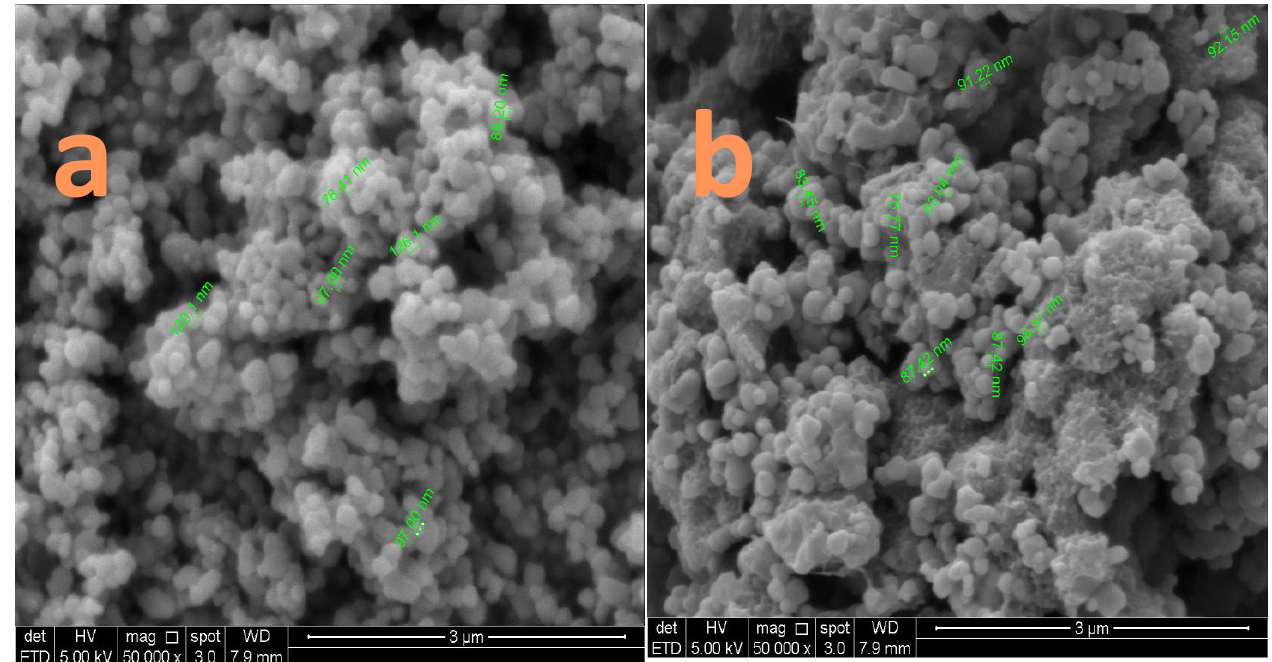
Figure 1. SEM image of ZnO ( a ) and ZnO/GO ( b ).